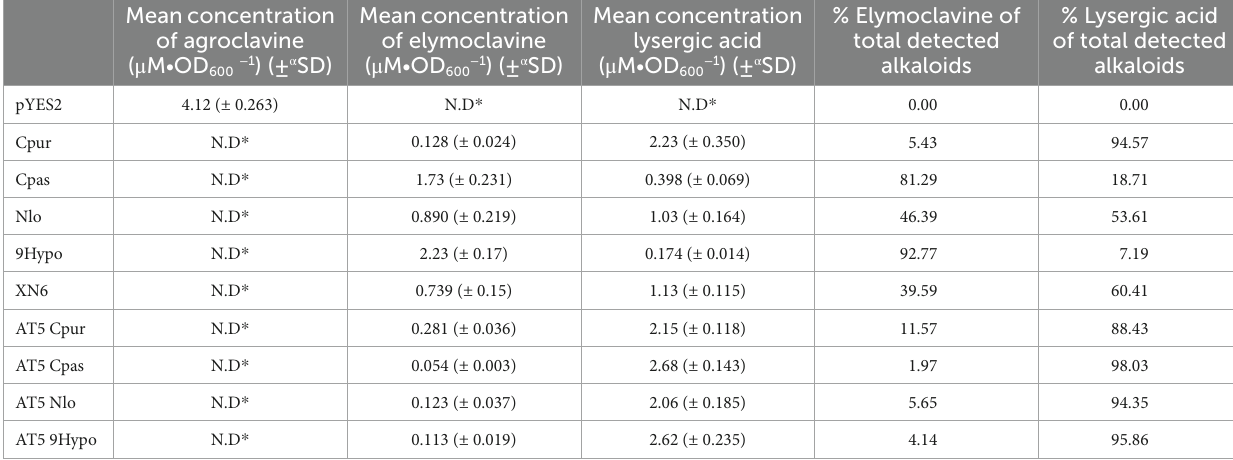
TABLE 4 Summary of the activity of chimeric AT5 cloA in the presence of agroclavine. Mean concentration of